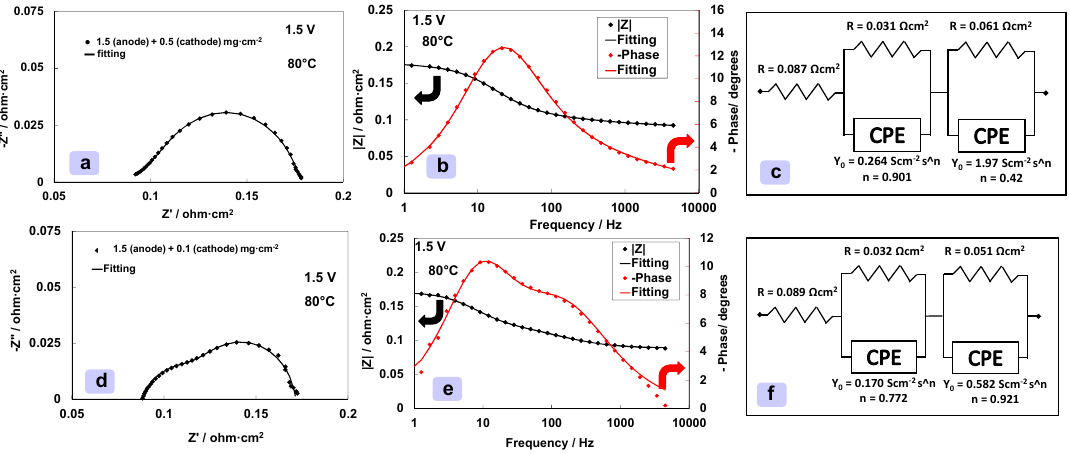
Figure 3. EIS at 1.5 V and 80 °C for high ( a – c ), 0.5 mg cm − 2 , and medium ( d – f ), 0.1 mg cm − 2 , cathode catalyst loading MEAs. Nyquist plots are reported in ( a ) and ( d ). Bode plots are reported in ( b ) and ( e ), equivalent circuits are reported in ( c ) and ( f ).